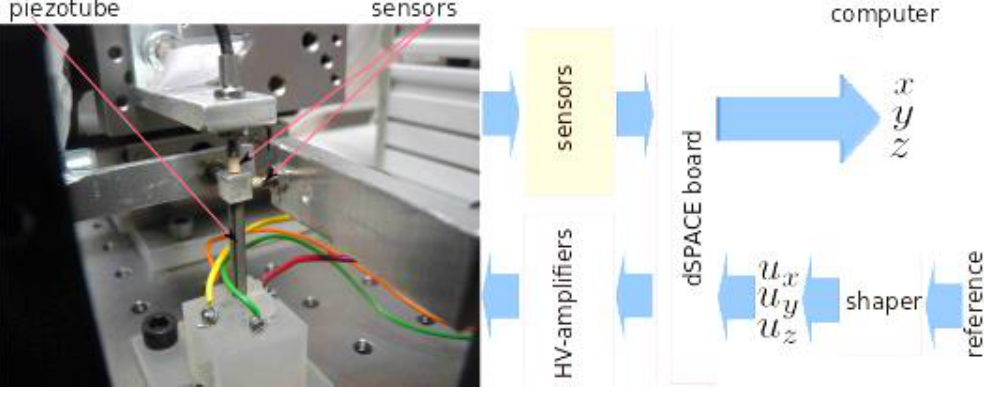
Figure 2. The experimental setup and its diagram.